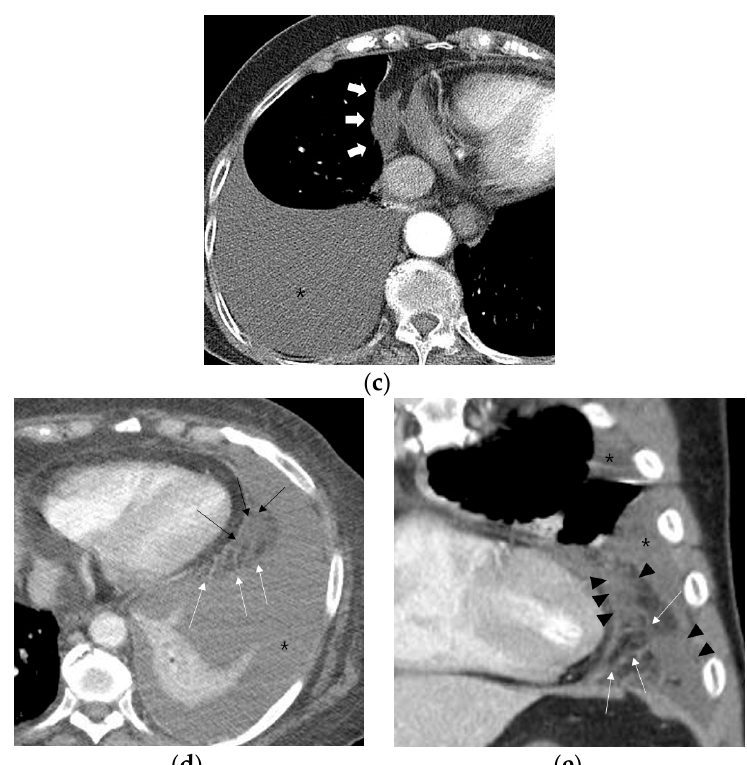
Figure 2. Representative cases demonstrating normal appearance, fat stranding, fluid collection, and phlegmonous appearance in the ipsilateral paracardiac fat on chest computed tomography. ( a ) Normal appearance of paracardiac fat on a coronal CT image at the level of left ventricle. Note a lack of fat stranding or a fluid collection in the paracardiac fat of a patient with pleural tuberculosis (white arrows). ( b ) A case of right pleural tuberculosis (asterisks) in a 67-year-old female with fat stranding (black and white arrows) in the right paracardiac fat on an axial CT image at the level of the right ventricle. ( c ) A case of right pleural tuberculosis (asterisk) in a 77-year-old female demonstrating a fluid collection (white arrows) in the right paracardiac fat on an axial CT image at the level of the left ventricle. ( d , e ) Two cases of left pleural tuberculosis (asterisk) with a phlegmon-like appearance in left paracardiac fat in a 74-year-old female on axial CT image ( d ), and in a 58-year-old male on coronal CT ( e ) at the level of the left ventricle. Note multiple fat strands (white arrows) interspersed with multiple fluid collections (black arrows or black arrowheads) in the paracardiac fat ipsilateral to the left pleural effusion.